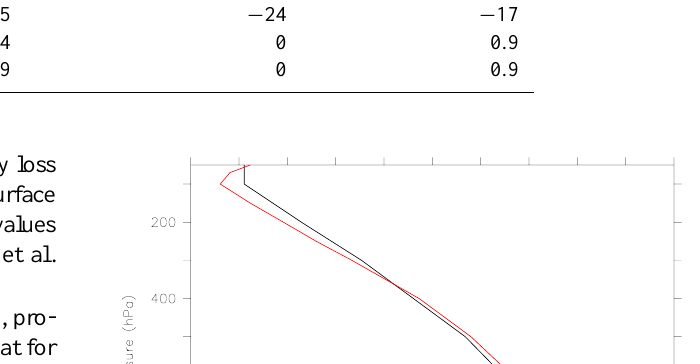
Table 2. The ensemble mean global mean radiation and heat flux budgets at the top of the atmosphere and the surface in the SPEEDO model compared to the results published by Kiehl and Trenberth (1997) and Trenberth et al. (2009). Positive values indicate downward fluxes. Flux or budget in Wm − 2 SPEEDO Kiehl and Trenberth (1997) Trenberth et al. (2009) TOA short wave radiation 227 . 3 235 239 . 4 TOA long wave radiation − 223 . 9 − 235 − 238 . 5 Surface short wave radiation 173 . 6 168 161 . 2 Surface long wave radiation − 69 . 0 − 66 Surface latent heat − 78 . 3 Surface sensible heat TOA budget